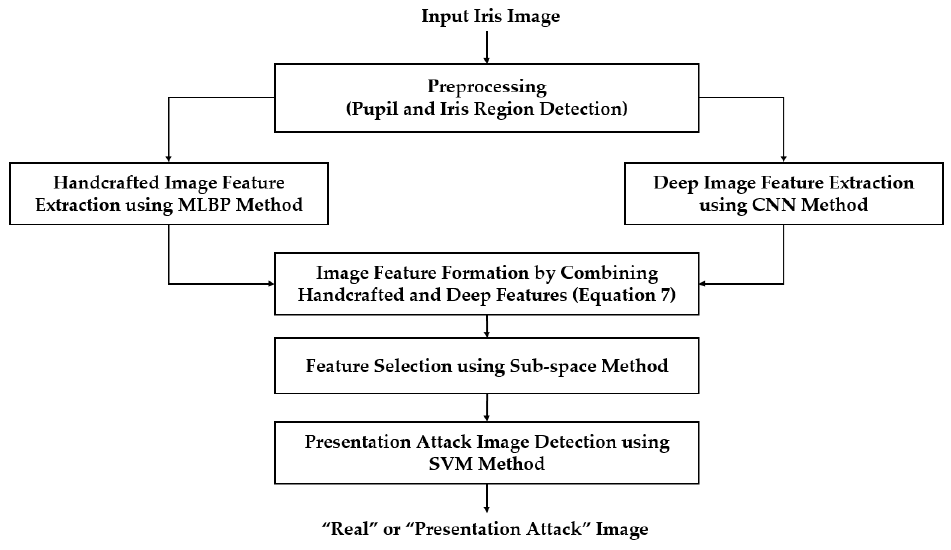
Figure 8. Flow chart of proposed iPAD method based on feature level fusion approach.